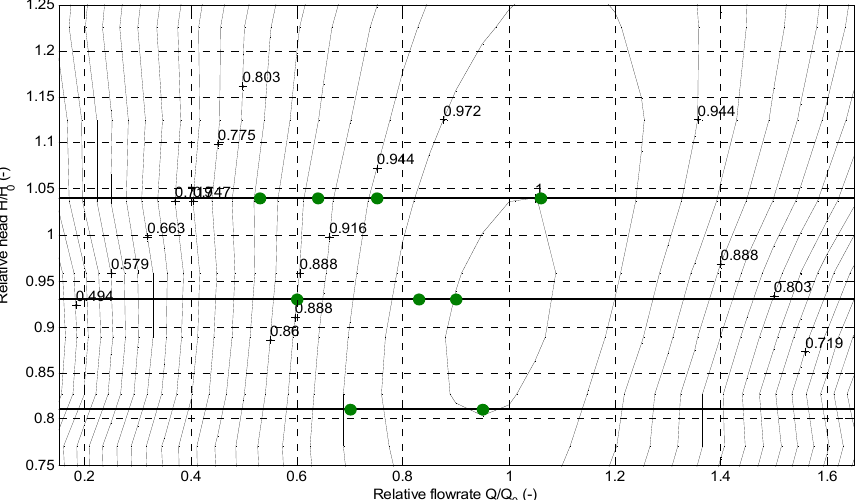
Figure 1. Efficiency chart of the turbine and operation regimes investigated in the numerical analysis.